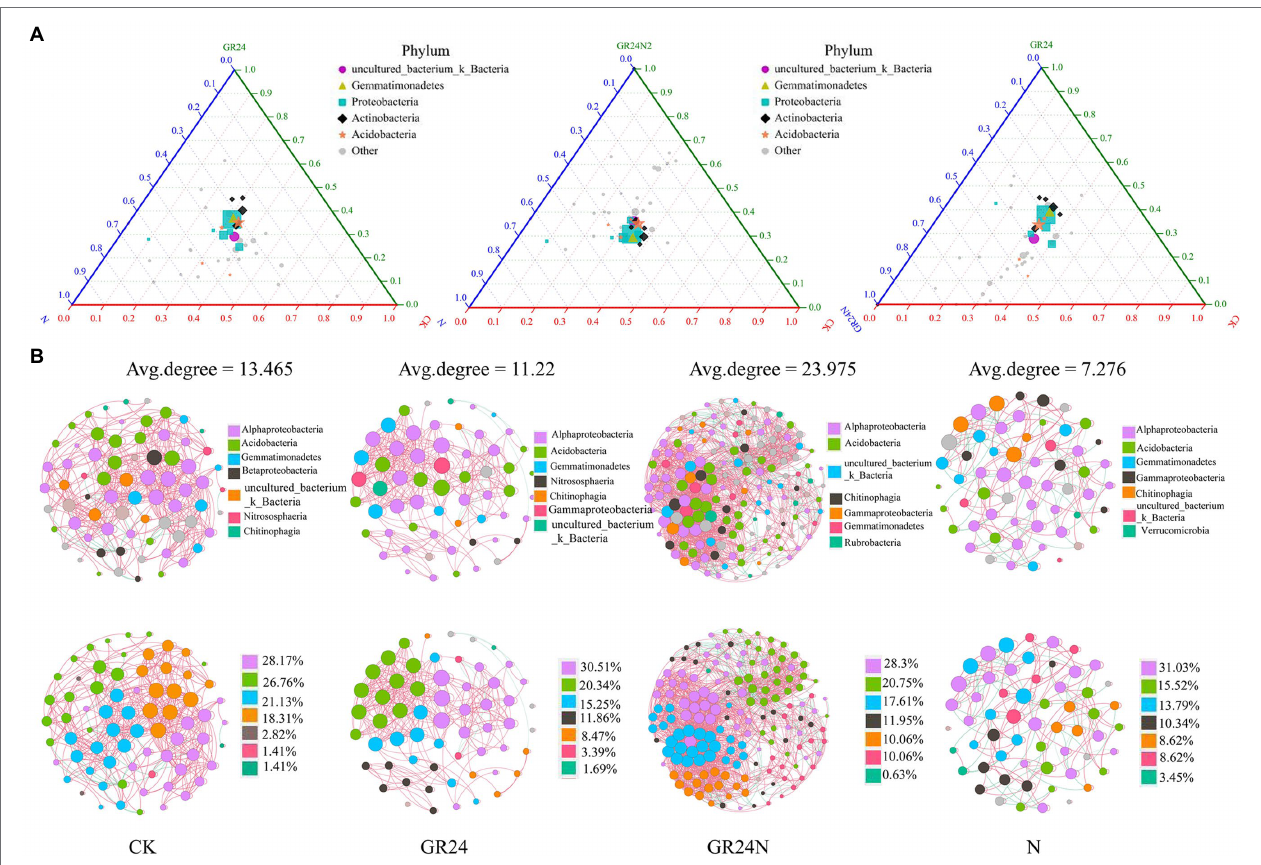
FIGURE 8 | Effects of additional N deposition and GR24 treatments on soil microbiome structures and diversities. (A) Ternary phase diagram of mock, additional N deposition and GR24 treatments soil microbiome. The species composition of the three groups of samples is compared and analyzed, and the proportion and relationship of different species in the samples can be visually displayed through the triangular graph. The circle in the triangle represents the species classification of all class levels contained under the phylum level, the size of the circle represents the average relative abundance of species, and the colored circle in the legend represents the species classification of the five phylum levels with the highest abundance. (B) Network of soil microbial populations additional N deposition and GR24 treatments at class level. Red lines indicate positive correlations and green lines for negative correlations. Node area is proportional to node degree calculated from each ASV abundance correlation. Correlation coefficients greater than 0.6 and P less than 0.05 were shown in the